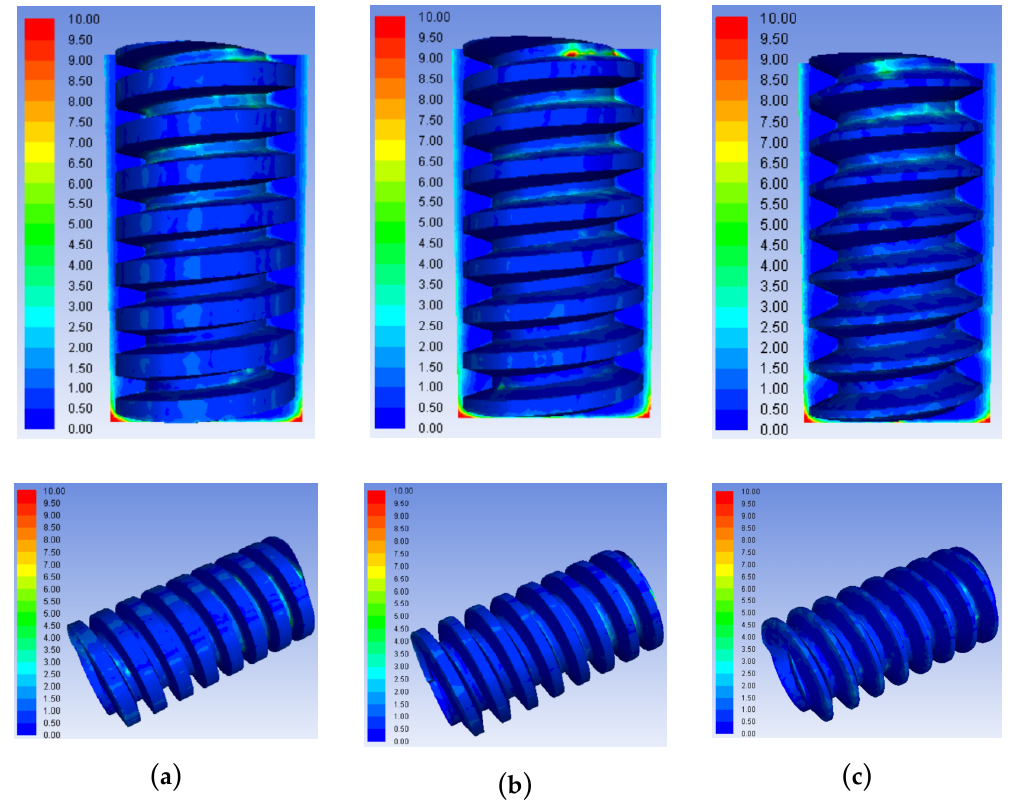
Figure 10. Concentration distributions of processing products in machining gaps and helical grooves using tube electrodes with different thread form angles: ( a ) 30°; ( b ) 45°; and ( c ) 60°.